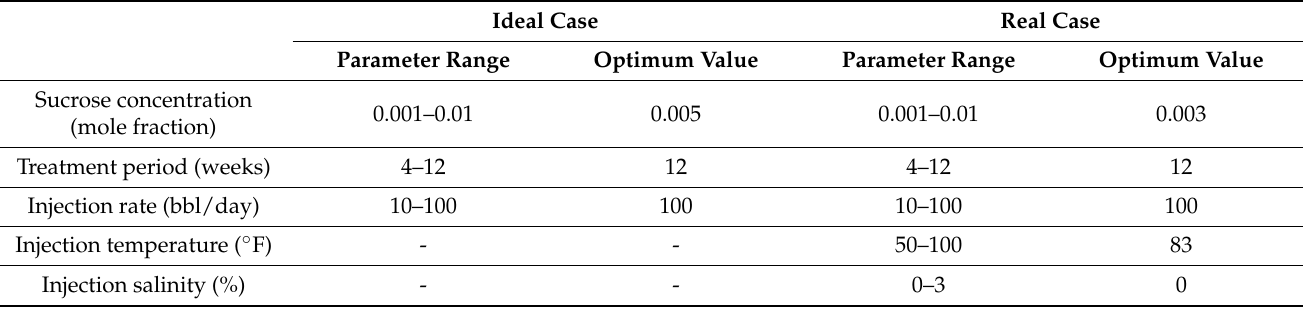
Table 2. Range of design parameters and optimization results.